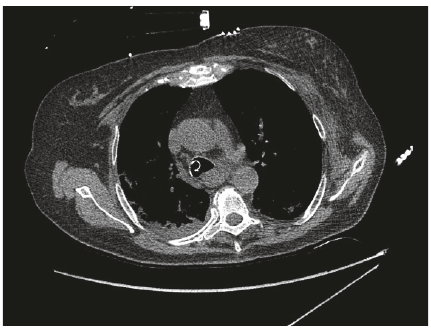
Figure 2: Moderate size hiatal hernia, esophageal enlargement diffusely with hyperdense material noted centrally within the stomach and distal esophagus. Given the history, this is concerning for gastric/distal esophageal hemorrhage but remains nonspecific. Acute sternal fracture was also